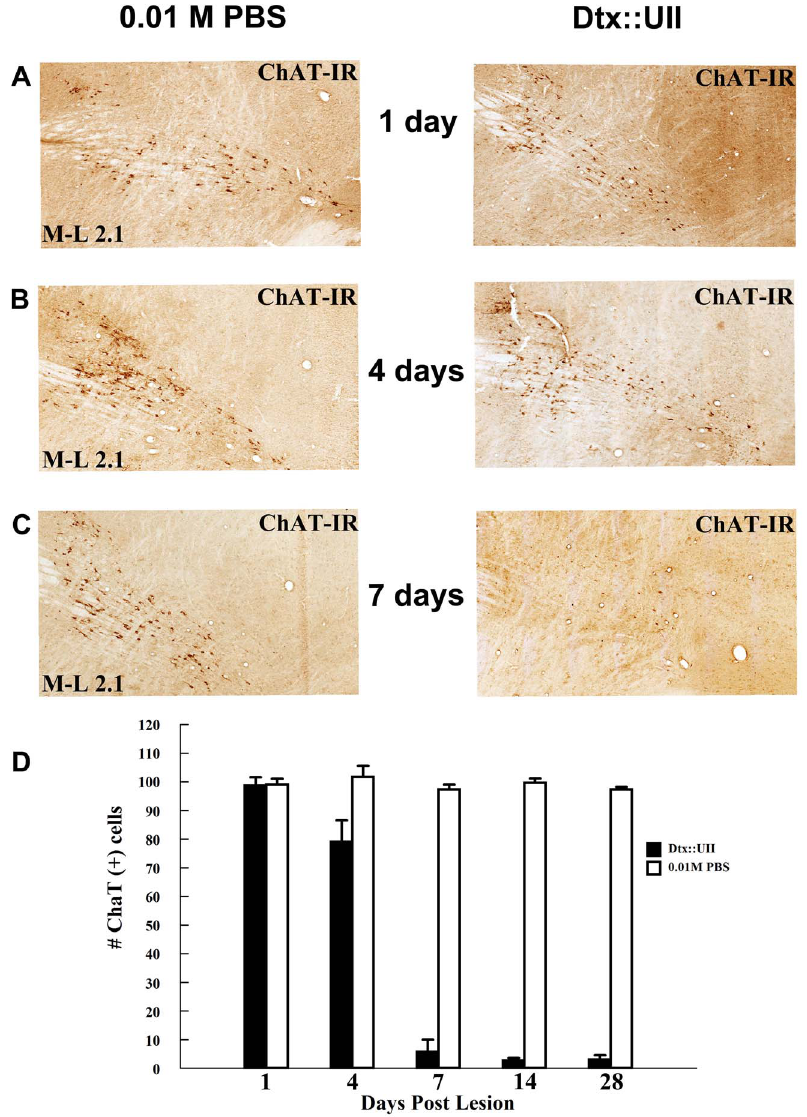
Figure 6. Time course of Dtx:UII-induced pedunculopontine tegmental nucleus cholinergic cell loss. Panels A-C: Representative sagittal PPTg sections under bright field microscopy showing choline acetyltransferase (ChAT) immunoreactivity (ChAT-IR; brown cells), 1 (A), 4 (B), and 7 (C) days following unilateral PPTg infusion of Dtx:UII (right panels) and vehicle (0.01 M PBS) infusion into the contralateral PPTg (left panels). Dtx:UII infusion induced a slight loss of PPTg ChAT-IR cells by 4 days post-infusion that became extensive by 7 days post-infusion. Panel D: Numbers of ChAT-IR positive cells counted at each of five time points (1, 4, 7, 14, and 28 days, n=3 per time point) following unilateral PPTg infusion of Dtx:UII (black bars) and vehicle infusion into the contralateral PPTg (white bars) hemispheres. Dtx:UII infusion significantly reduced the number of ChAT-IR cells by 4 days post-infusion. Error bars represent 6 SEM.